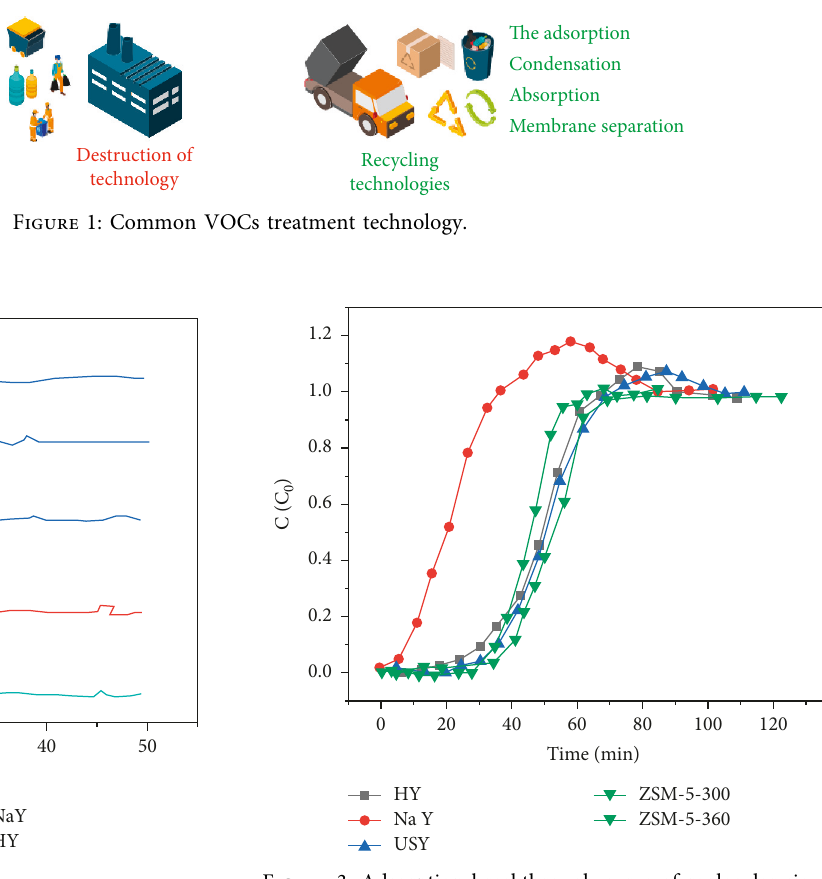
Figure 2: XRD patterns of the mixture of HY, Na Y, USY, ZSM-5- 300, and ZSM-5-360 molecular sieves and silica sol.